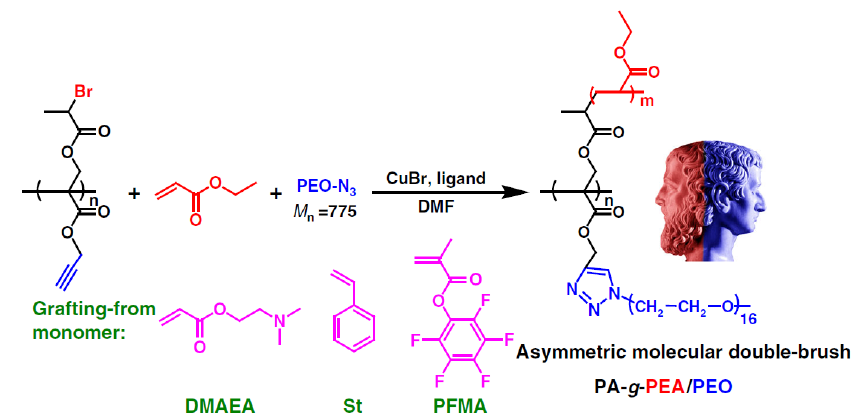
Figure 10. Synthesis of Janus armed bottlebrush copolymer by concurrent ATRP and CuAAC click chemistry. Adapted with permission from [67], Copyright© 2017 Springer